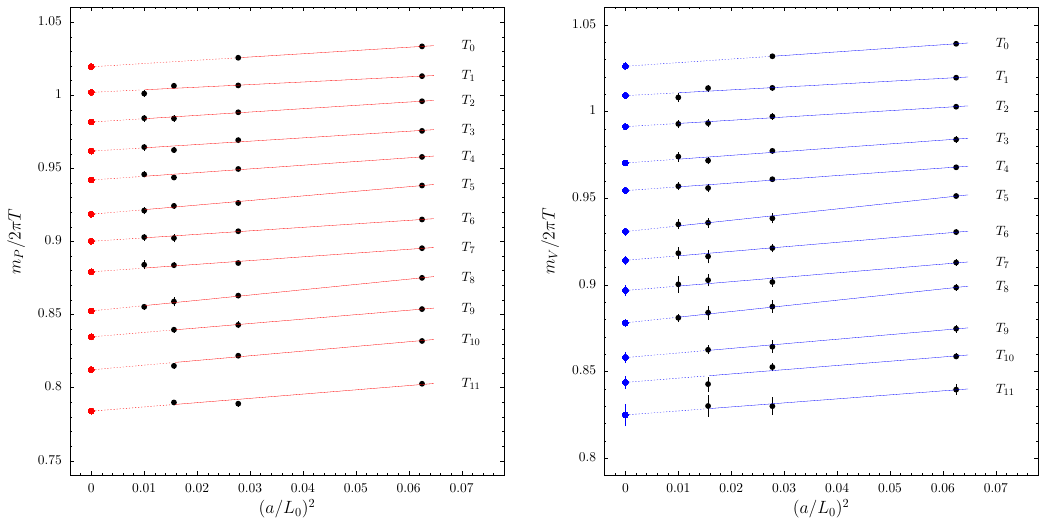
Figure 2 . Numerical results for the tree-level improved pseudoscalar (left panel) and vector (right panel) screening masses at finite lattice spacing (black dots). The lines in the panels represent the linear extrapolations in ( a/L 0 ) 2 to the continuum limit. Each temperature is analyzed independently from the others. Data corresponding to T i ( i = 0 , . . . , 11 ) are shifted downward by 0 . 02 × i for better readability.